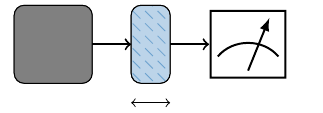
r FIG. 2. Pictographic illustration of strong state complexity (Definition 2). A blackbox either outputs a (known) pure state = ( 1 / d ) I . ρ = | ψ (cid:7)(cid:8) ψ | , or the maximally mixed state ρ 0